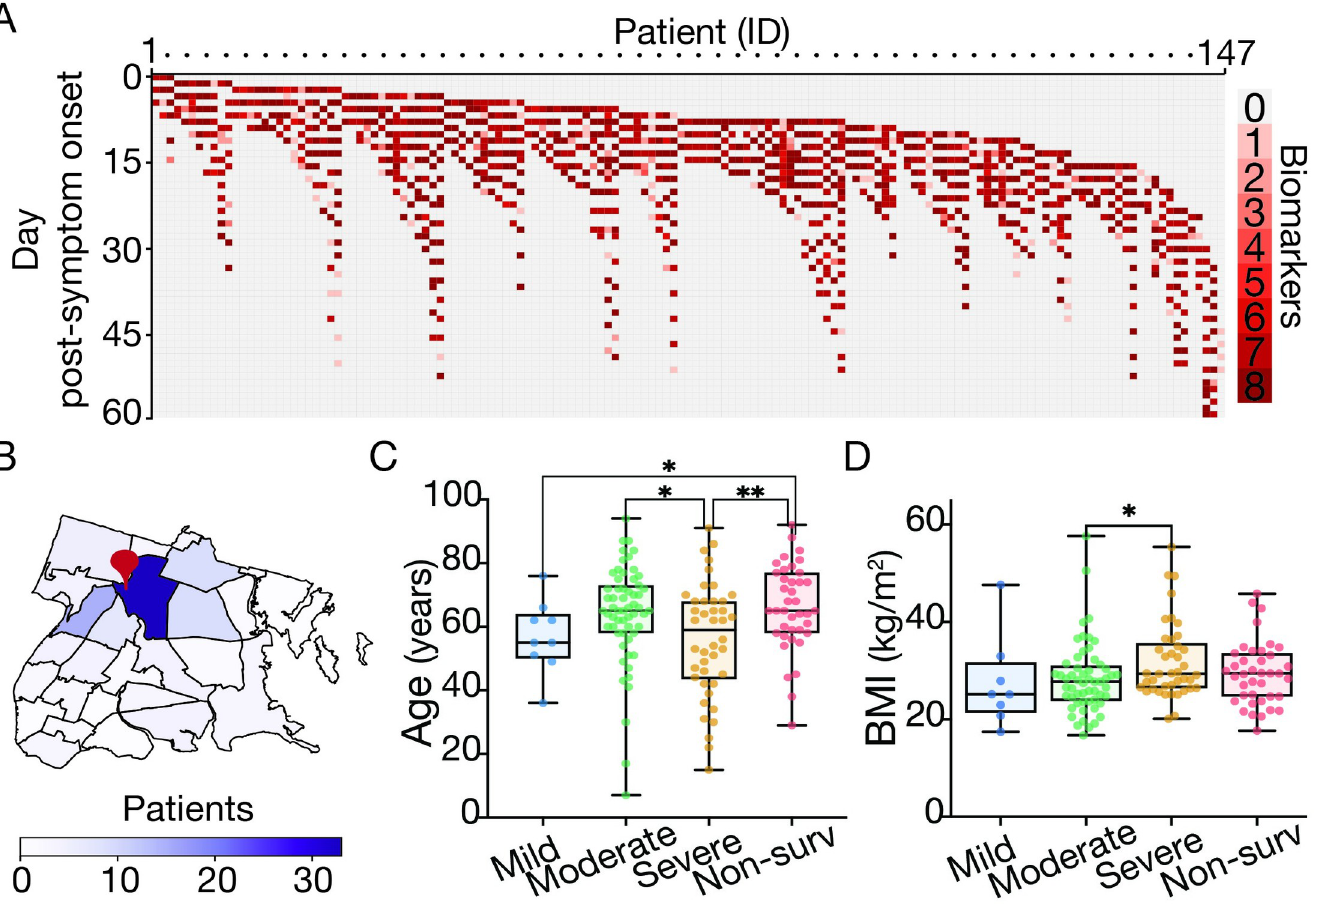
Fig 1. Overview of patient cohort by sampling strategy, residence and demographic associations with COVID-19 disease severity. (A) Heatmap describing the number of biomarkers (y-axis; up to eight different biomarkers, see materials and methods) measured for any given patient (x-axis; described by an internal identifier) and day PSO over course of hospitalization (patients = 147, blood samples analyzed = 1,954). (B) Choropleth map of the Bronx zip codes colored by the number of patients enrolled in the study. The red pin denotes the location of Montefiore Medical Center. (C-D) Box plot of patient’s age (C) and Body Mass Index (D) by oxygen supplementation or non-survival outcome (Blue: Mild, green: moderate, orange: severe, red: non-survival). Boxes extend from the 25 th to 75 th percentiles, the whiskers represent the minimum and maximum values and the middle line corresponds to the median. Statistical significance is denoted with asterisks (Mann-Whitney; � p < 0.05, �� p < 0.01). We define “day post-symptom onset” (PSO) as the day relative to the patient-reported onset of symptoms. We downloaded the raw data to make the map from NYC Open Data (https://data.cityofnewyork.us/City-Government/Borough-Boundaries/tqmj-j8zm) and plotted it using pandas and geopands.